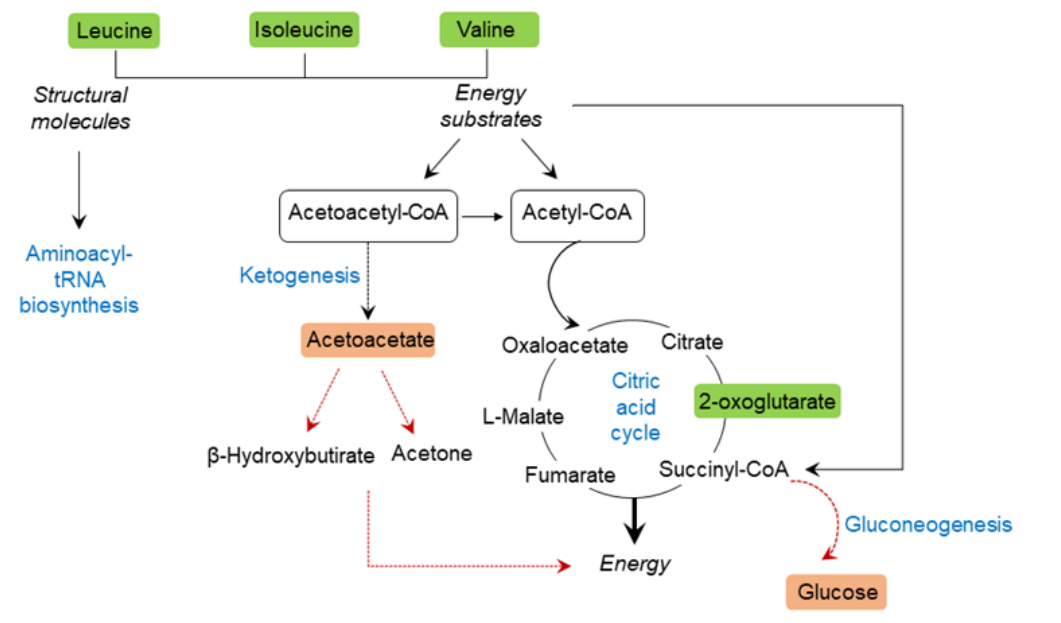
Figure 6. Schematic representation depicting the interrelationships of the disturbed metabolic path- ways identified by 1 H NMR urine analysis. Green (significantly increased), and red (not significantly increased), as compared to ZDF ( p < 0.05 is significant).